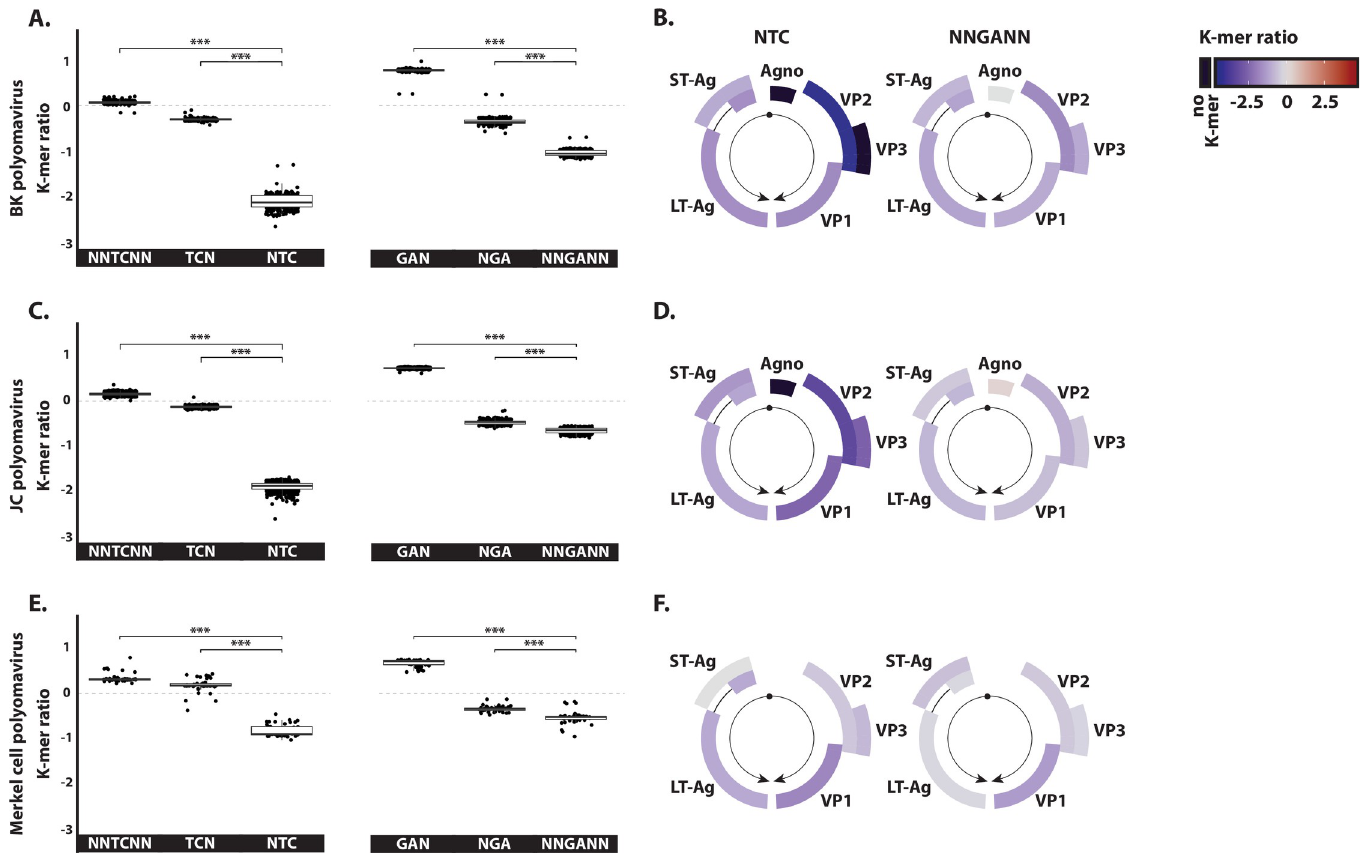
Fig 2. Evidence of an A3 footprint in human polyomaviruses. The observed/expected ratios of TC dinucleotide at various codon positions and on both strand (i.e. NNTCNN, TCN, NTC, GAN, NGA and NNGANN) were calculated for BK polyomavirus (panels A-B), JC polyomavirus (panels C-D) and Merkel cell polyomavirus (panel E-F). For the dot plots, each point stands for a unique full-length viral genome. Median and quartile are depicted by a boxplot. P-values were calculated by Student’s unpaired, two-tailed t-test (NS for not significant, � p < 0.05, �� p < 0.01, ��� p < 0.001). Panels B, D and F illustrate NTC and NNGANN ratios for the different viral coding sequences. A colored scale with increasing shades of blue indicating depletion and increasing shades of red indicating enrichment. Replication origin is illustrated by a black dot and gene transcriptional orientation is symbolized by black arrows.